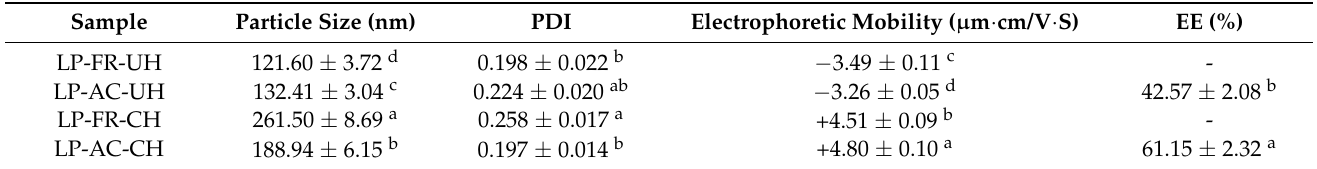
Table 1. Mean Particle size, PDI, zeta potential, and membrane fluidity of fabricated